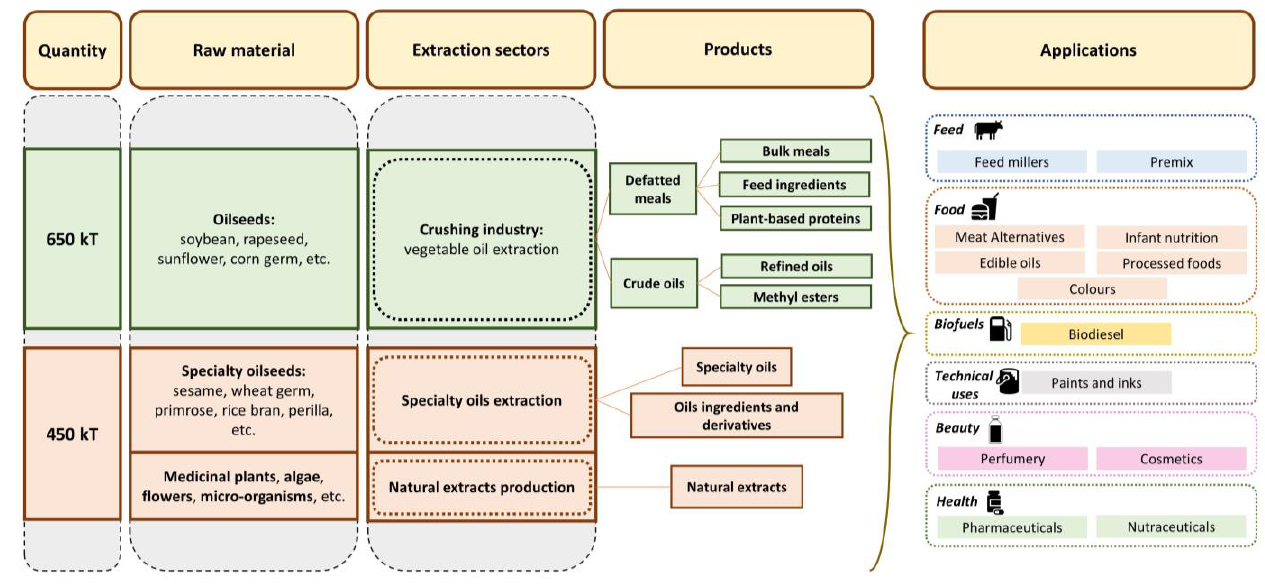
Figure 2. Hexane value chain: products and applications.